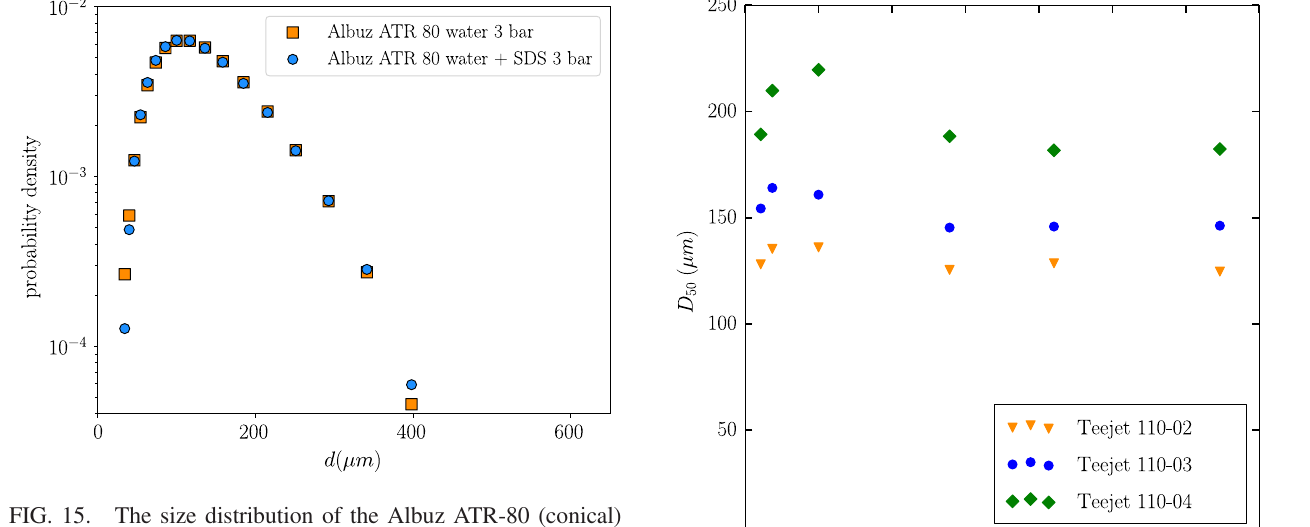
15. The size distribution of the Albuz ATR-80 (conical) nozzle at 3 bar with pure water and with a surfactant (SDS) at CMC. There is no visible difference between the two